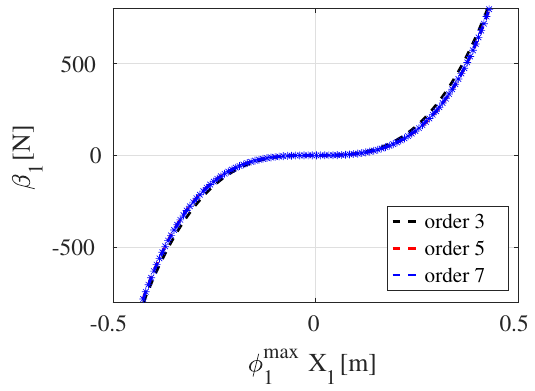
Figure 12. Illustration of the fitting procedure for the ICE method on the cantilever beam. Blue stars represent the outputs obtained from static applied force on the FE model, and the dashed curve is the fitted polynomial; black: order 3, red: order 5, blue: order 7. The range of displacements in the x -axis corresponds to half the length of the cantilever